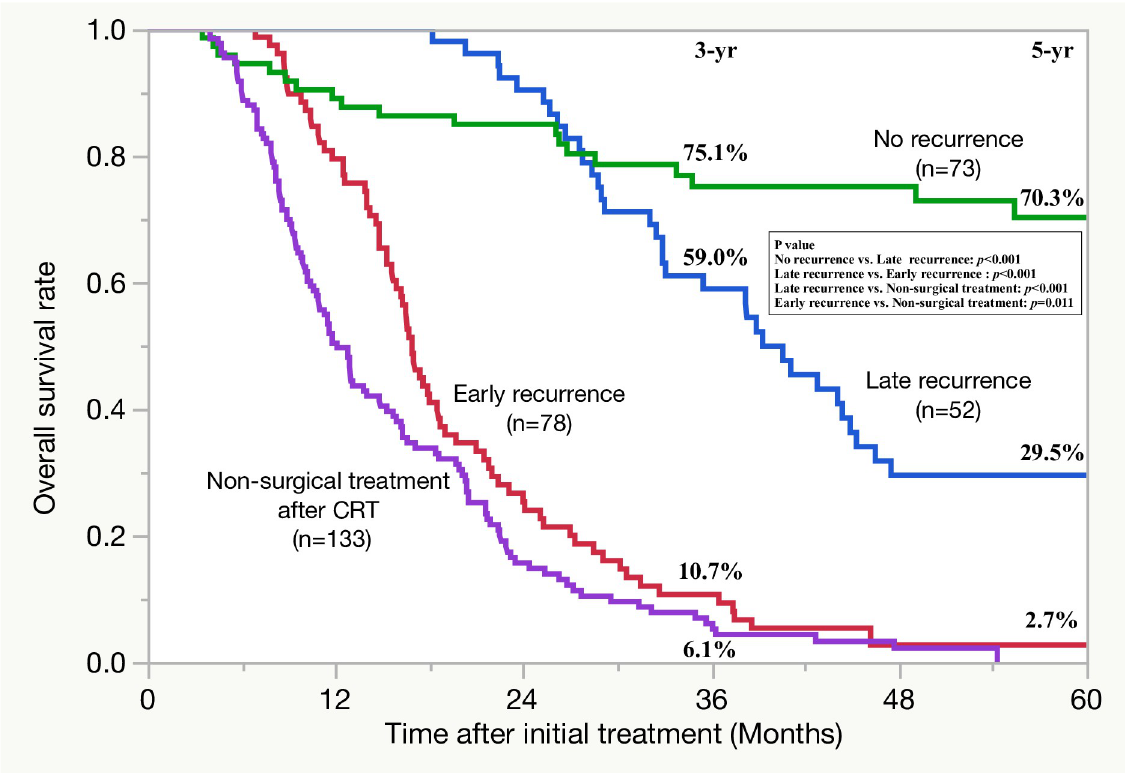
Fig 2. Comparison of the overall survival curves after initial treatment between the early and late and no recurrence and non-surgical treatment after CRT groups.